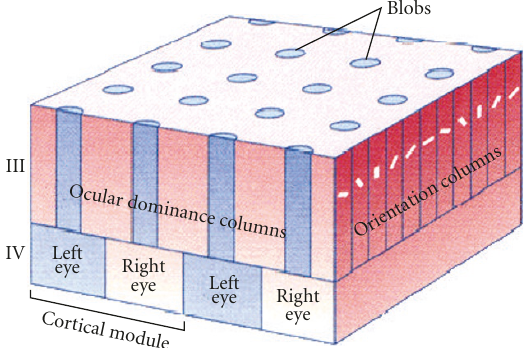
Figure 2: Illustration of a hypercolumn containing neurons selec- tive to orientation, ocular dominance, and color, obtained from [40].